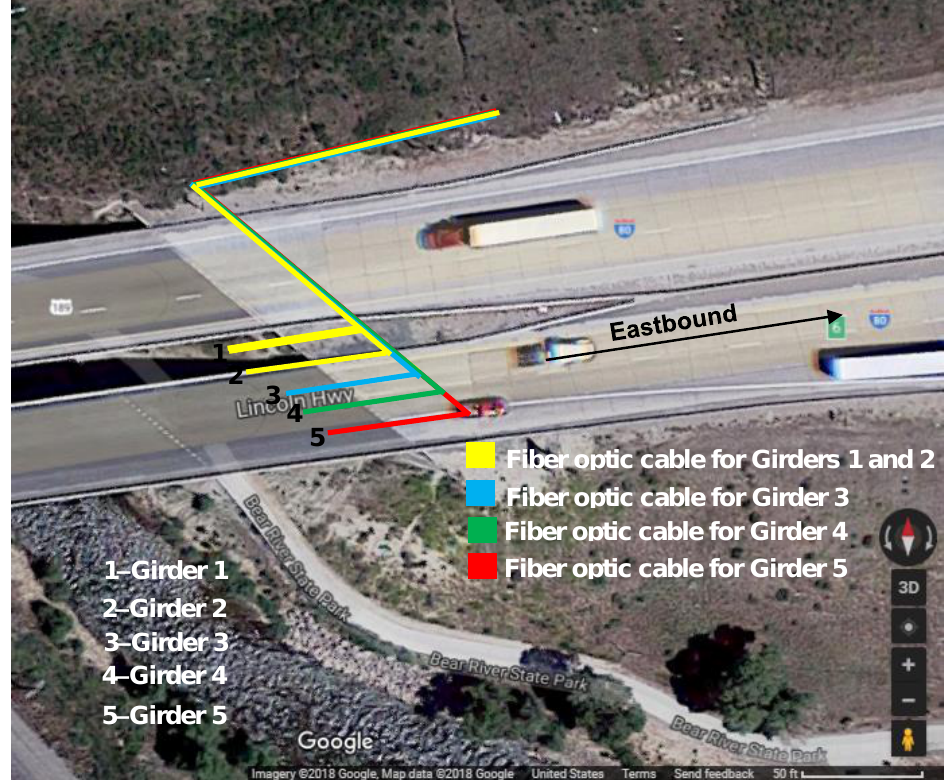
Figure 9. Fiber optic system for the bridge with the flange-only array.